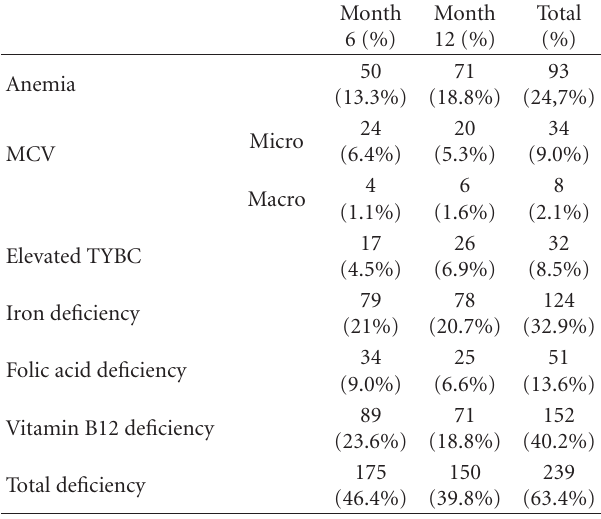
Table 4: 12 Month evaluation of all RYGB